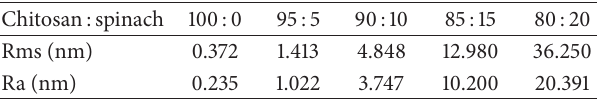
Table 2: Surface analysis data of the chitosan film and chitosan- spinach blend